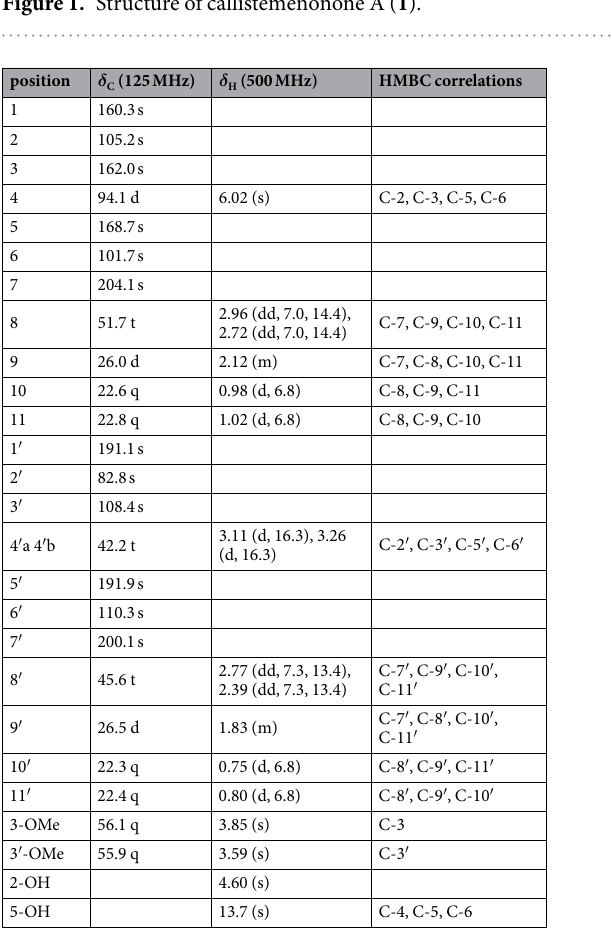
Figure 1. Structure of callistemenonone A ( 1 ).